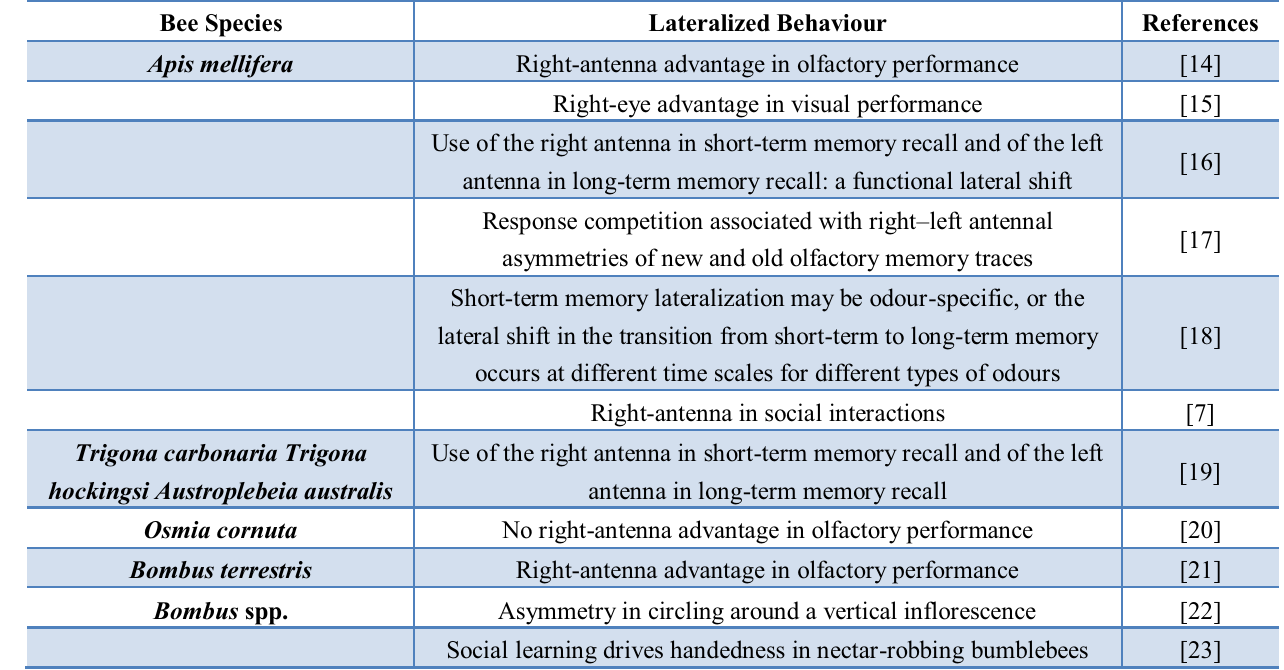
Table 1. Summary of the behavioural studies reported in Section